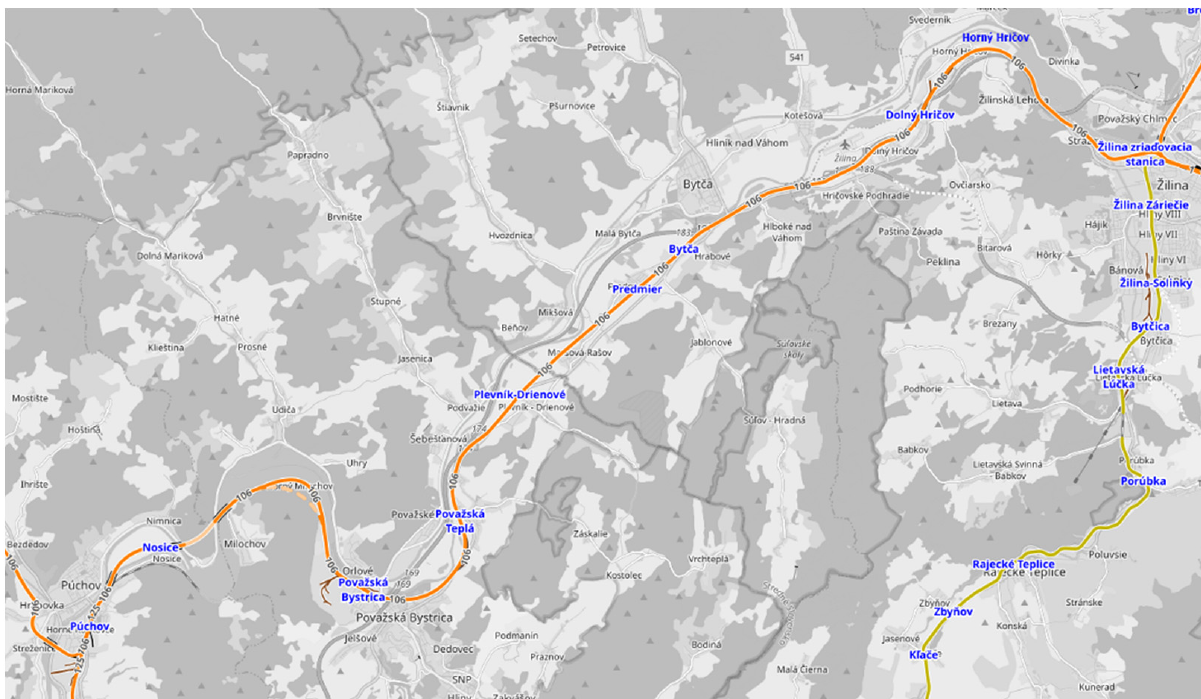
Figure 4. Track section Žilina–Púchov with railway stops and train stations.